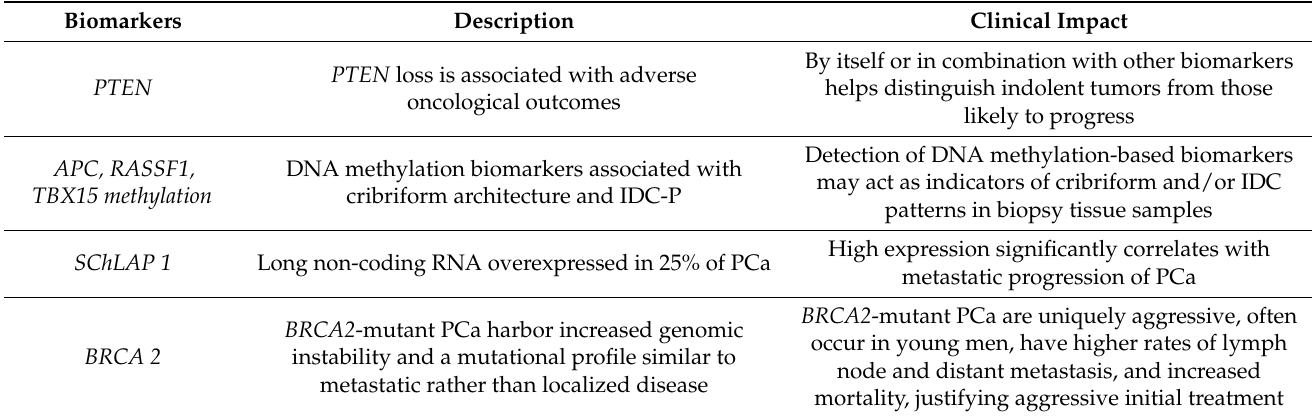
Table 1. Tissue biomarkers in predicting upgrading and/or significant disease in prostate cancer (IDC-P: prostatic intraductal